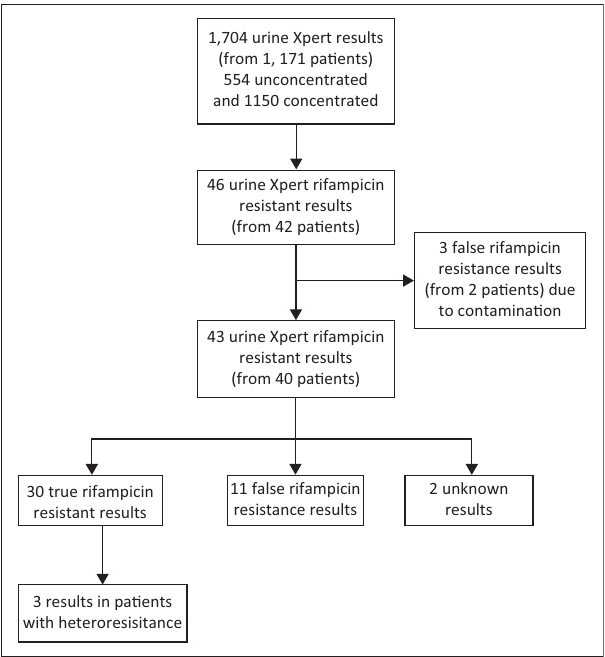
FIG URE 1: Overview of urine Xpert rifampicin resistance results from two cohorts of hospitalised HIV-patients in Cape Town, South Africa.